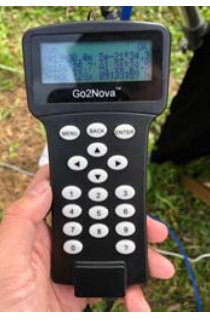
Figure 1 . Go2Pro Controller (cid:2) CEM25P and CEM60 mount (See Figure 2)